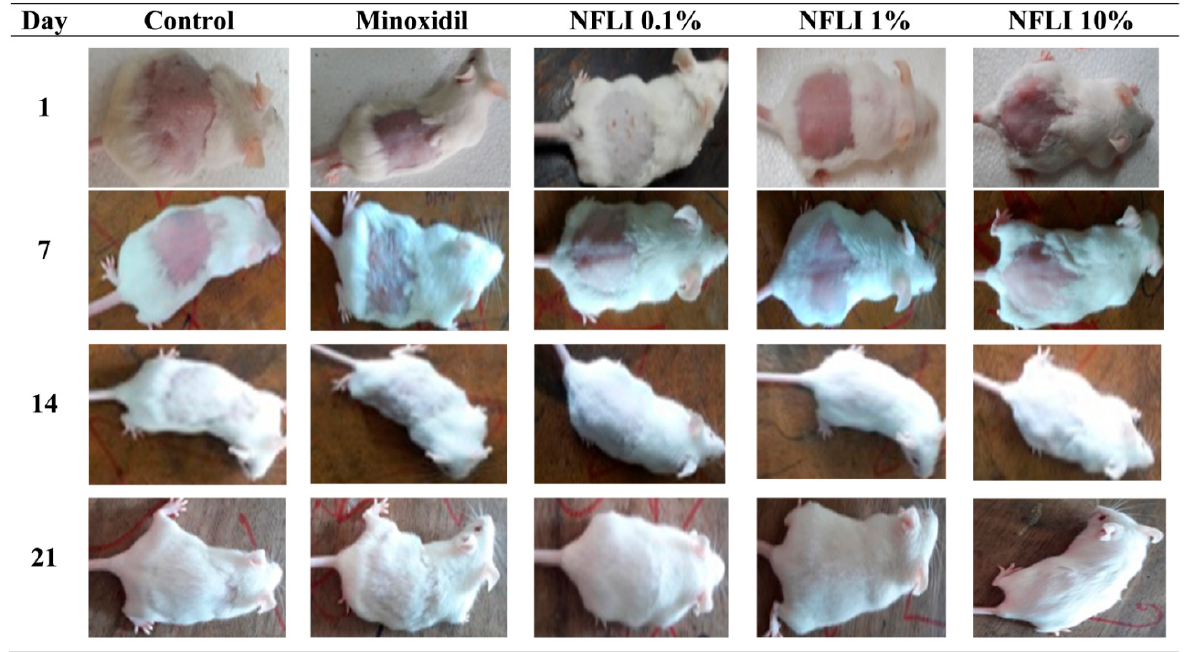
Figure 4. Hair growth-promoting effects of the n -hexane fraction of L. indica (NFLI) and minoxidil in mice after 1, 7, 14, and 21 days.